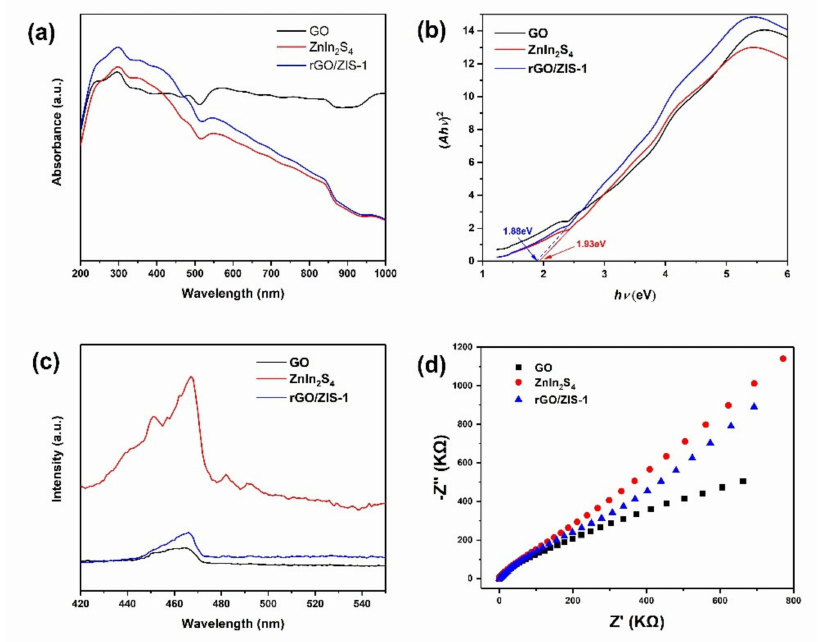
Figure 4. ( a ) UV–vis di ff use reflectance spectra and the corresponding ( b ) α h υ 2 versus h υ curves of the GO, ZnIn 2 S 4 and rGO / ZIS-1; ( c ) PL spectra; and ( d ) EIS Nynquist plots of GO, ZnIn 2 S 4 , and rGO /